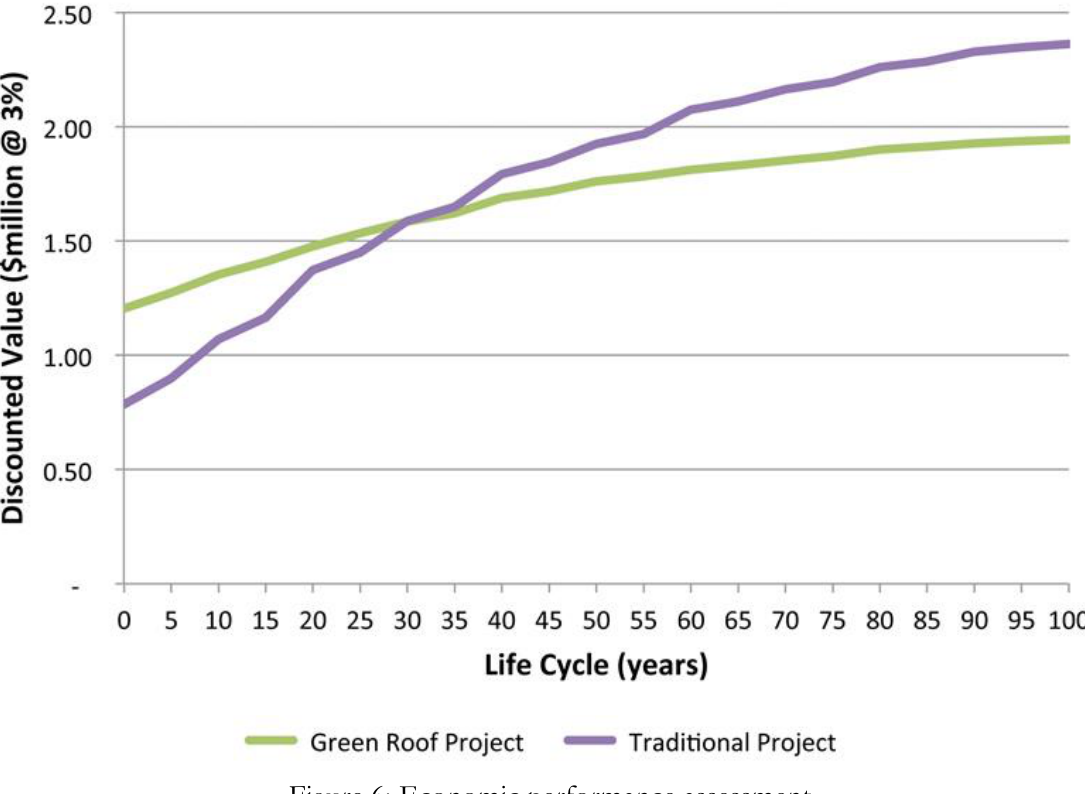
Figure 6: Economic performance